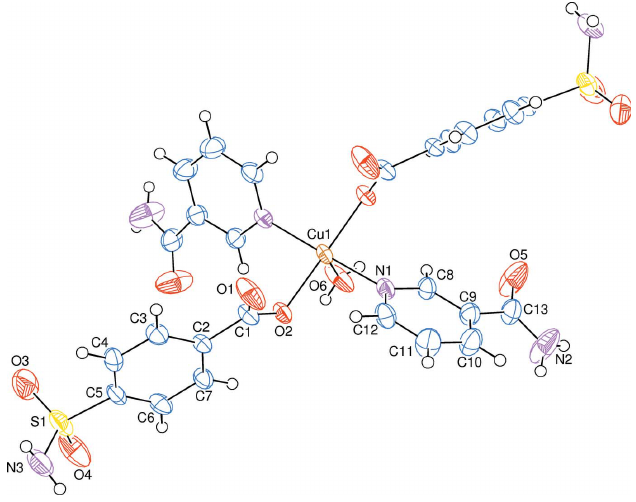
Figure 1 The molecular structure of the title complex with the atom-numbering scheme. Unlabelled atoms are related to labelled ones by the symmetry (cid:3) z . Displacement ellipsoids are drawn at the 50% operation 1 (cid:3) x , y , 3 2 probability level.